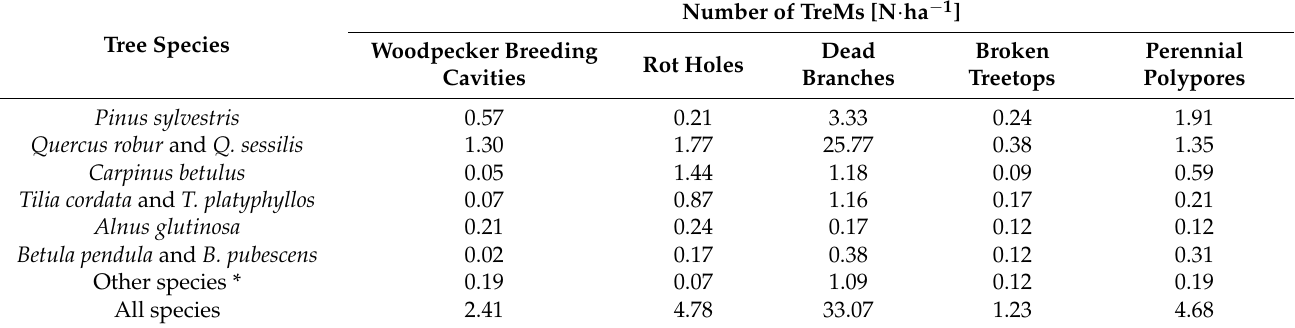
Table 2. Number of TreMs in the studied tree stands.